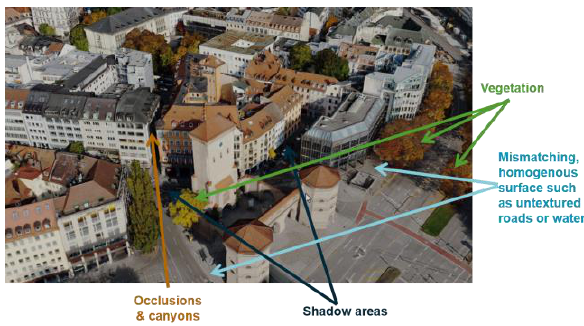
Figure 11: Advantage of LiDAR for 3D Mesh